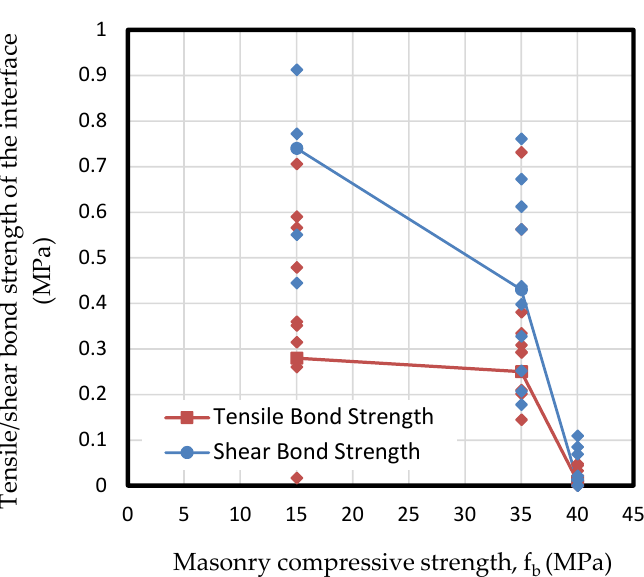
Figure 6. Results of tensile and shear bond strength of the interface depending on the masonry compressive strength (f b ).